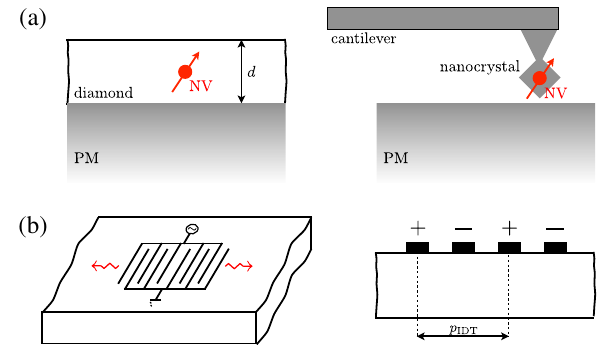
FIG. 3. (a) Schematic illustration for coupling to a NV center via a piezomagnetic (PM) material (see text for details); surface grooves (not shown) can be used to provide SAW phonon confinement. (b) SAWs can be generated electrically based on standard interdigital transducers (IDTs) deposited on the surface. Typically, an IDT consists of two thin-film electrodes on a piezoelectric material, each formed by interdigitated fingers. When an ac voltage is applied to the IDT on resonance (defined = 2 π ¼ v =p by the periodicity of the fingers as ω , where v s s IDT IDT is the SAW propagation speed), it launches a SAW across the substrate surface in the two directions perpendicular to IDT fingers